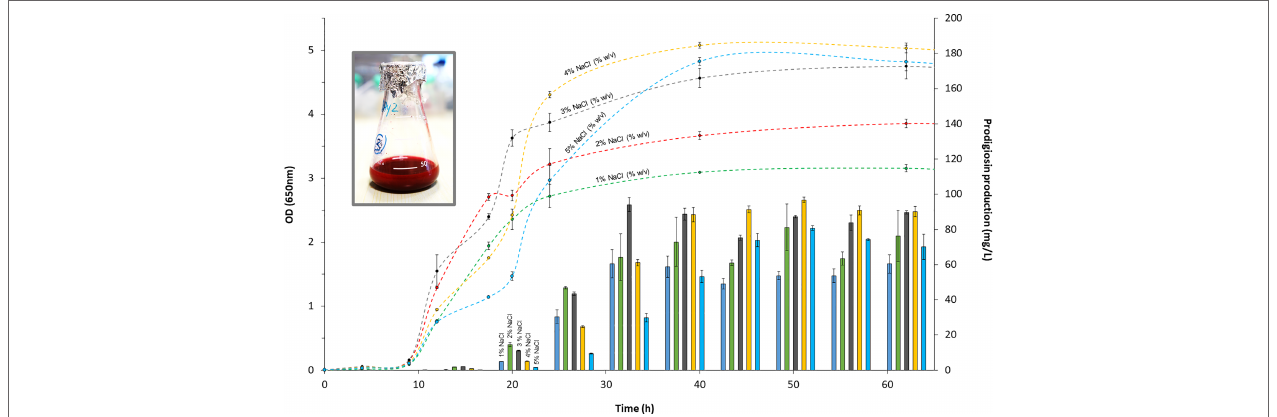
FIGURE 1 | The growth profile and the production of prodigiosin at different concentrations of NaCl. V. gazogenes PB1 was cultivated in minimal media at 28°C over a period of 3 days in the presence of 1 - 5% (w/v) NaCl. OD values at 650 nm are shown with dashed lines, while prodigiosin production is shown with solid